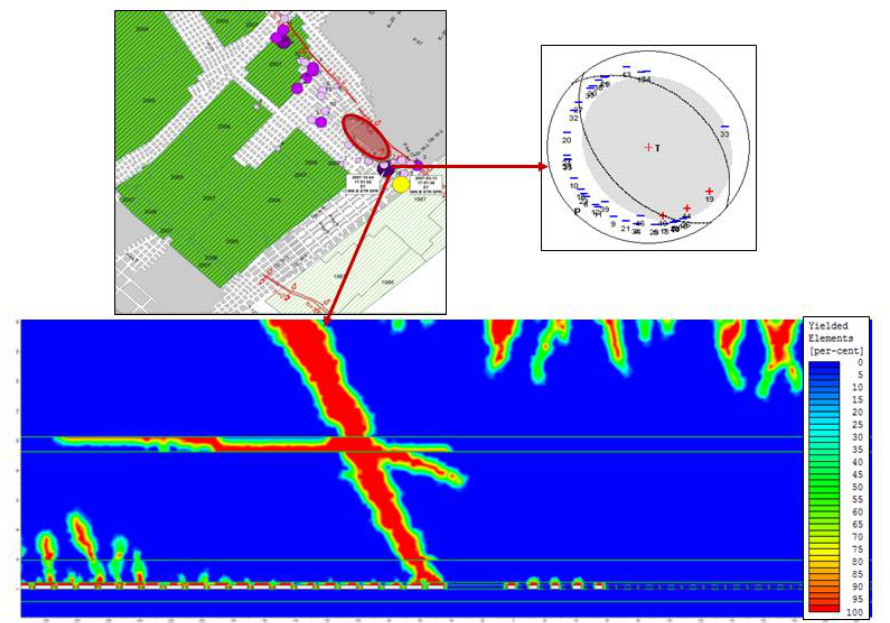
Figure 4. E7 seismic event which occurred in October 2007 at the edge of the created remnant with its probable mechanism [13].